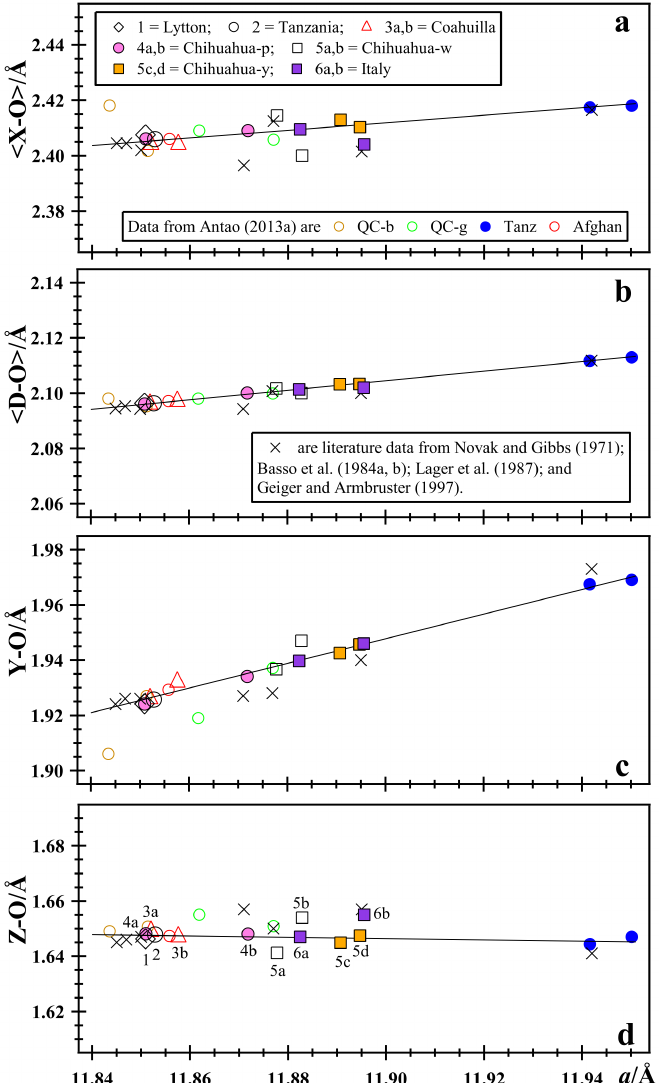
Figure 19. Structural variations for grossular samples. ( a ) Average <X-O>, ( b ) mean <D-O>, ( c ) Y-O, and ( d ) Z-O distances vary linearly with the a unit-cell parameter that range from 11.840 to 11.951 Å. The range on the y -axis (0.08 Å) is the same in each plot, so the differences in each plot can be compared (also from the slopes of the trend lines). Straight lines are meant as guide to the eyes. The Z-O distances are nearly constant. The average <X-O> and <D-O> distances change by small amounts compared to the Y-O distance that changes the most and has the steepest slope. The Y site controls the structural variations. Data from Antao [1] for grossular samples from Quebec, Tanzania, and Afghanistan are shown as open circles. Single-crystal data for seven samples are shown as triangles [87–91]. Errors bars are smaller than the symbols. Data from this study shows details that were not observed in previous SCXRD studies, which is an inappropriate technique to examine multiphase